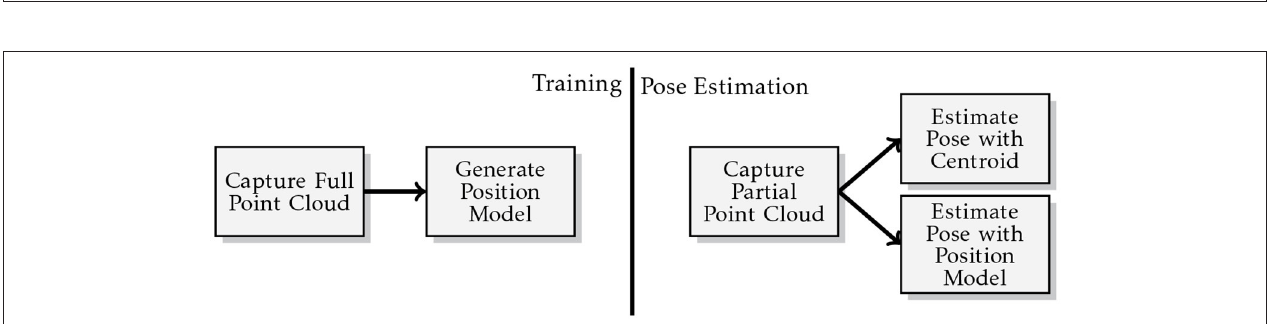
FIGURE 7 | (Left) Mean prediction accuracy measures each over 50 pushes when applying congruent, incongruent, and adaptive models to a cube and a cylinder. (Right) Results for object position estimation accuracy for position model and centroid based techniques. Mean prediction accuracy measures each over 100 runs is taken for the position model based technique meanwhile the output of the centroid technique is constant for a given input.